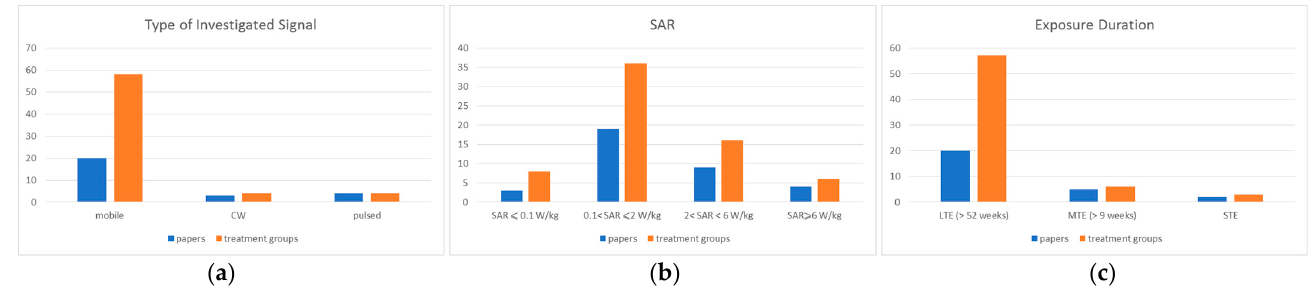
Figure 3. Distribution of papers and treatment groups for the ( a ) used frequency, ( b ) SAR dose and ( c ) duration.